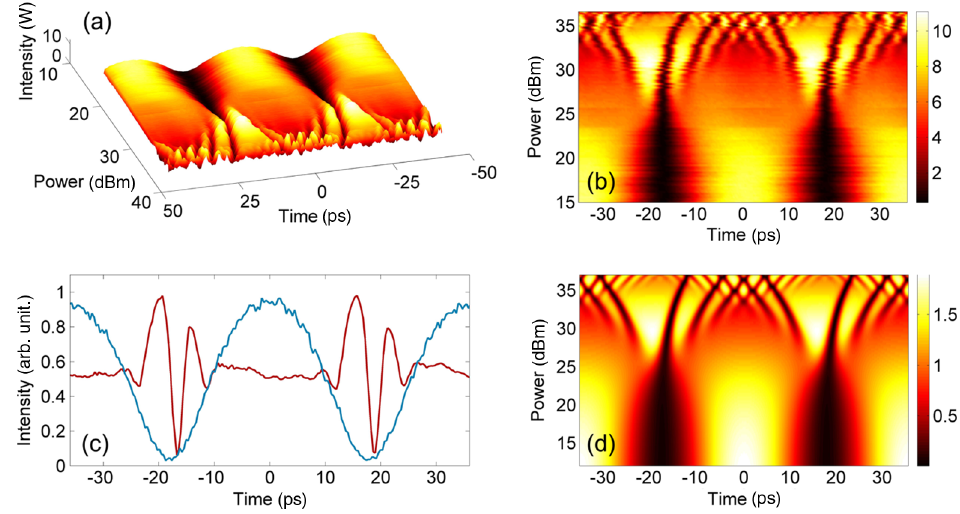
FIG. 5. Measured UB dynamics for the pump-signal input configuration (asymmetric dual-pumped FWM, η ¼ 0 , α ¼ 0 . 3 ). (a) 3D surface of measured output power vs time and input power. (b),(d) Color-level plot of the output power profile at different input powers from measured data (b) and numerical simulations of the dimensional NLS equation (d). (c) Temporal OSO trace at P ¼ 30 . 6 dBm, showing the onset of asymmetric oscillations (the solid blue line stands for the